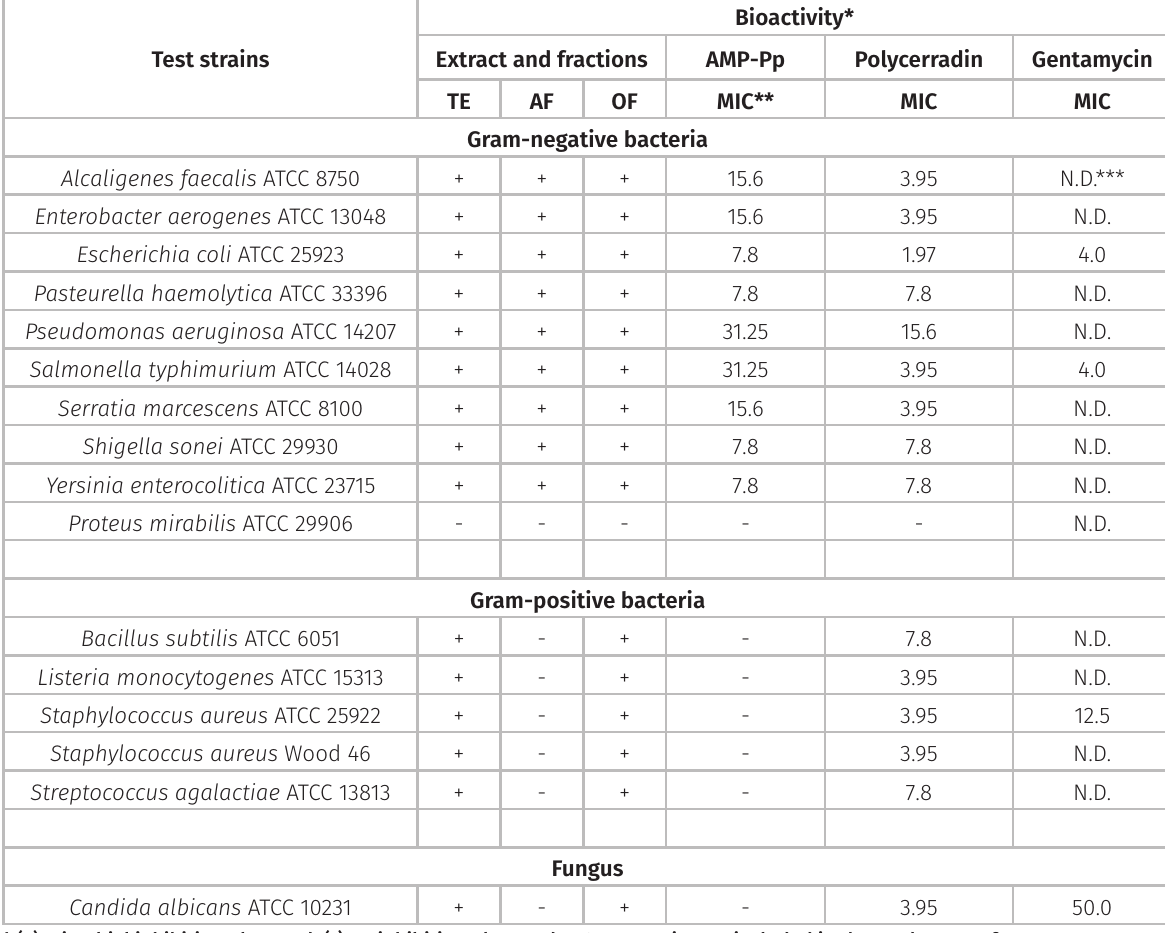
Table I. Antimicrobial spectrum of TE, AF, OF, AMP-Pp and polycerradin found in the fermentation broth of P. polymyxa RNC-D §